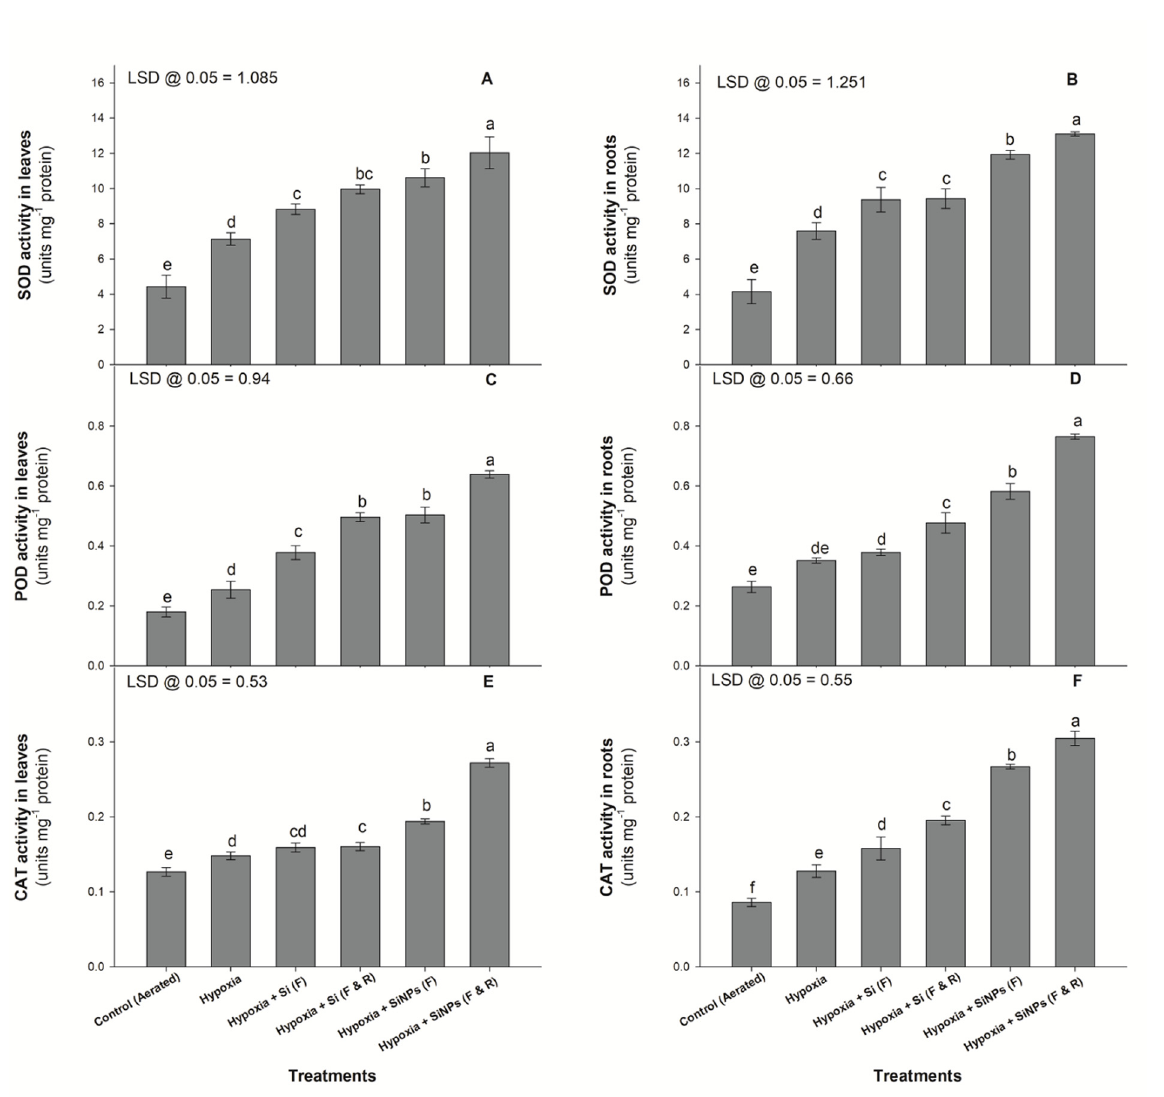
Figure 3. SOD ( A , B ), POD ( C , D ), and CAT ( E , F ) activities in leaves and roots of blueberry plants in response to six treatments i.e., (i) control (aerated), (ii) hypoxia, (iii) hypoxia + Si (F), (iv) hypoxia + Si (F & R), (v) hypoxia + SiNP (F), (vi) hypoxia + SiNPs (F & R). Values are mean of four independent replicates ( n = 4) ± SE (shown in vertical bars), and values denoted by different letters (in small alphabets) differ significantly at p < 0.05, using the LSD test. The abbreviations used are CAT: catalase; F: foliar application of Si or SiNP; F & R: combined foliar and root zone application of Si; POD: peroxidase; R: root zone application of Si or SiNP; Si: conventional silicon; SiNPs: silicon nanoparticles; SOD: superoxide